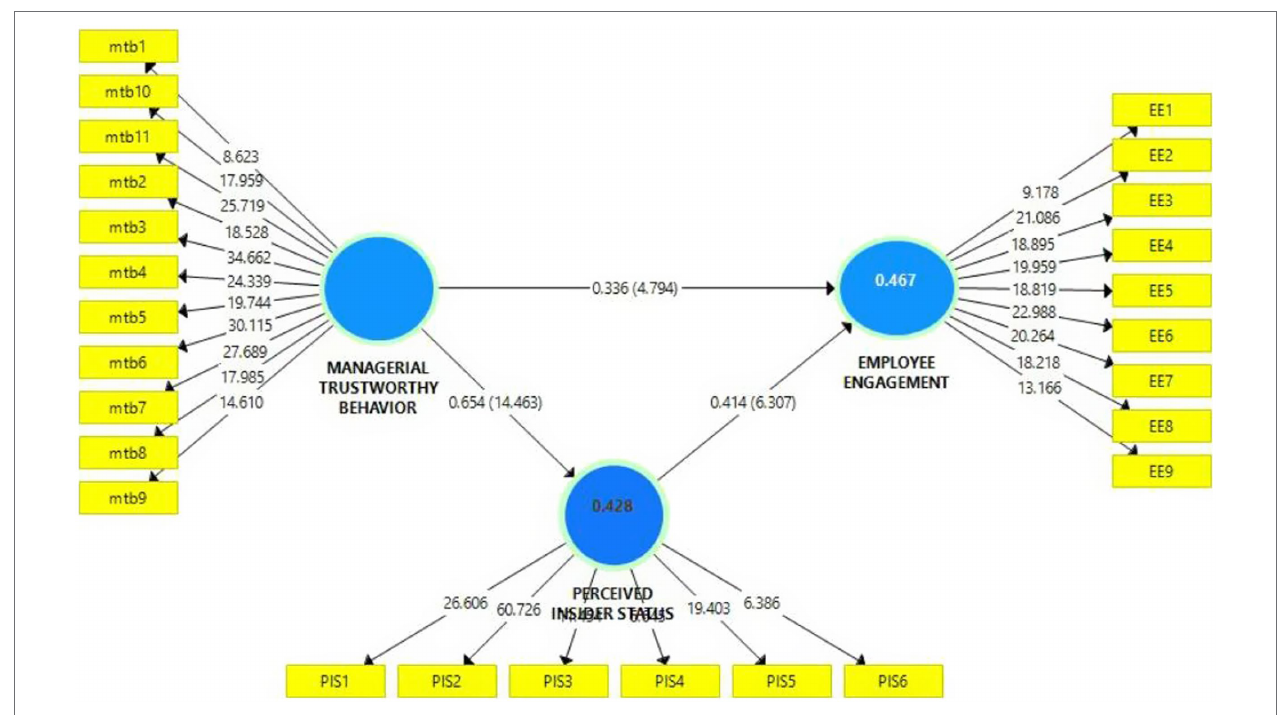
FIGURE 2 | Structural model.